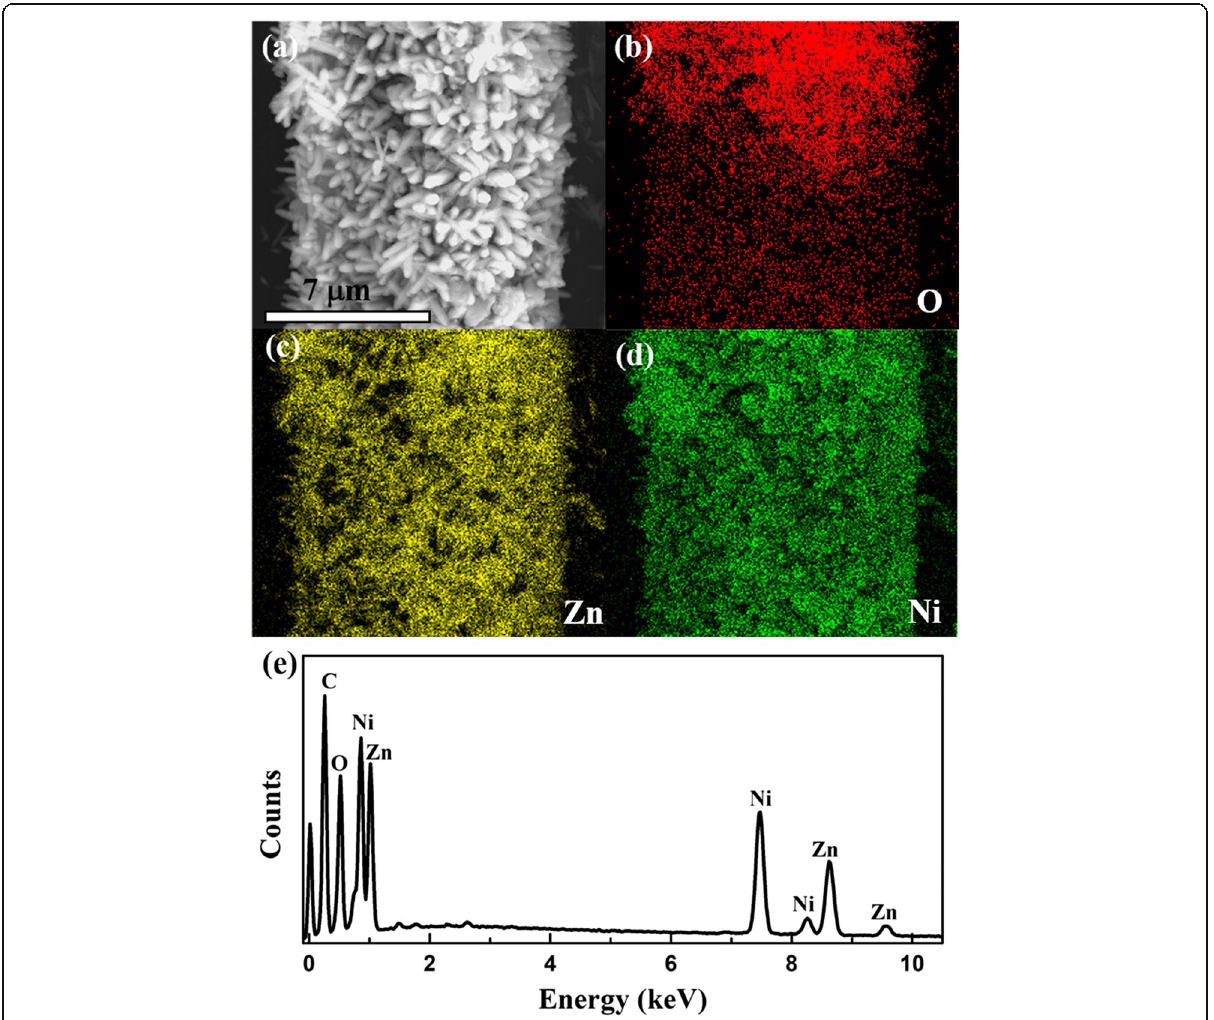
Fig. 4 Typical energy dispersive X-ray spectroscopy (EDS) elemental mapping images of ZN2. a The corresponding SEM image of the mapping area. b O mapping. c Zn mapping. d Ni mapping. e EDS